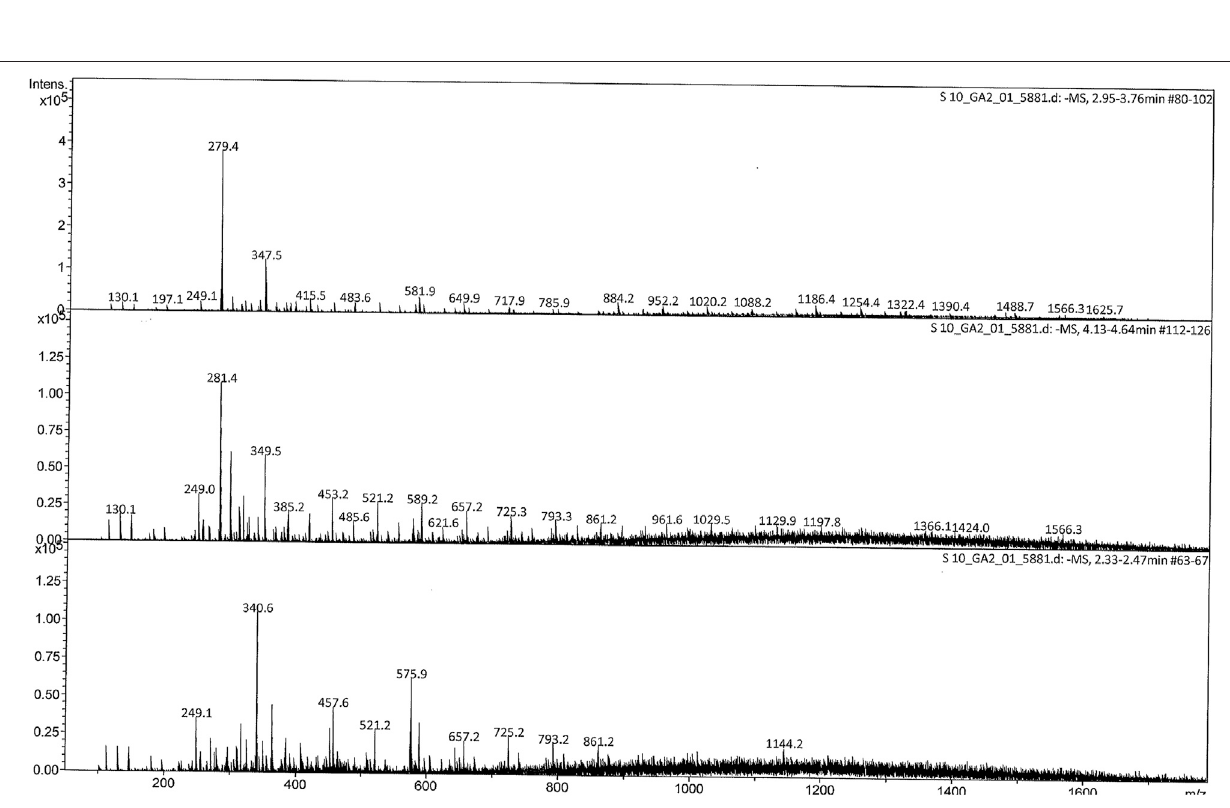
Frontiers in Pharmacology |